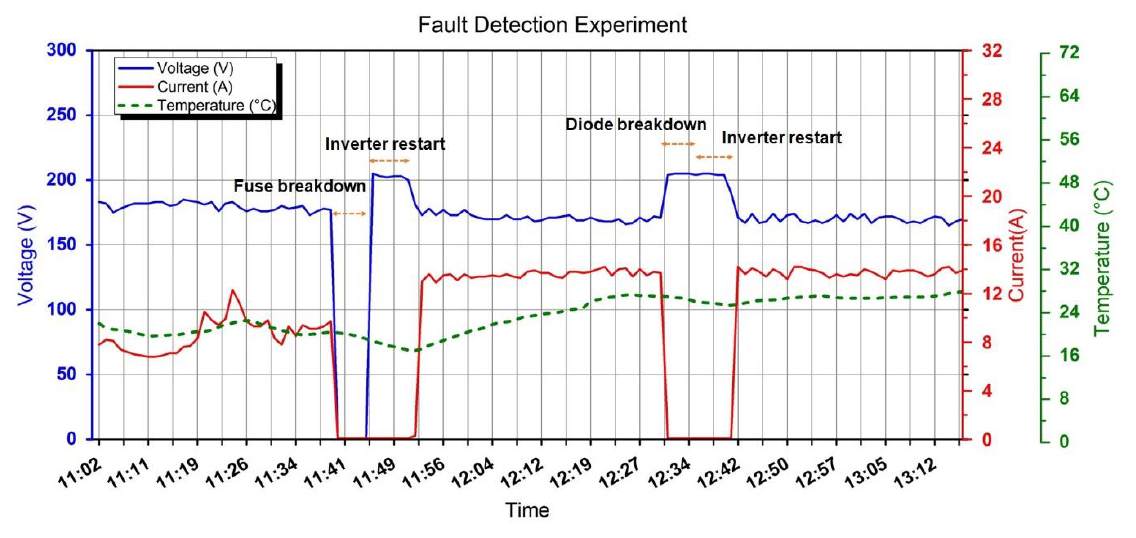
Figure 11. The result of fault detection experiment obtained in database.